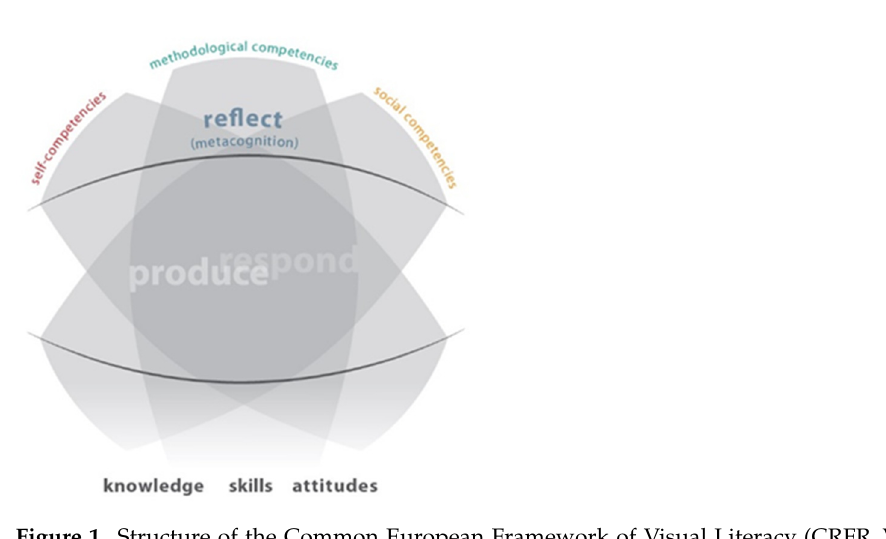
Figure 1. Structure of the Common European Framework of Visual Literacy (CRFR_VC (ENViL Structural Model 2016)).